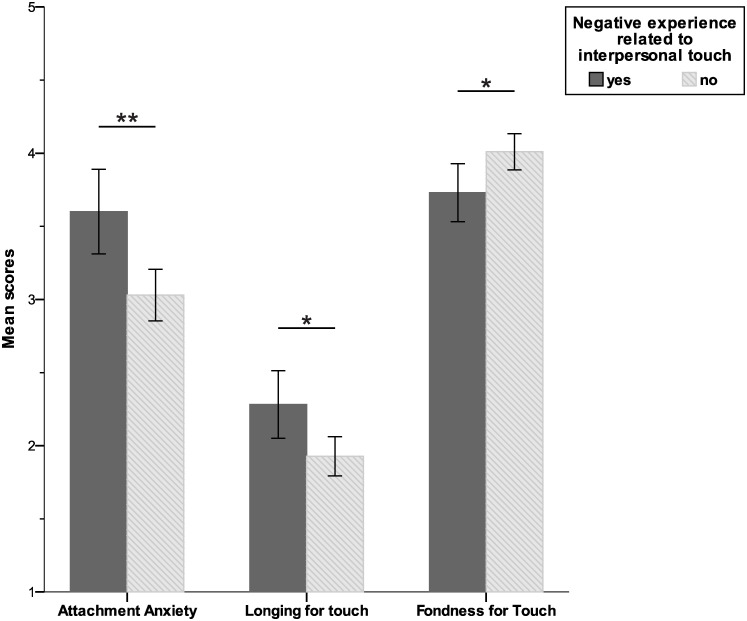
Attachment and touch exposure upon reporting of negative experiences in TBIO.Significant differences in attachment and touch attitudes in participants with and without past negative experiences regarding interpersonal touch. Error bars represent standard error of the mean. * p < .05, ** p < .001.